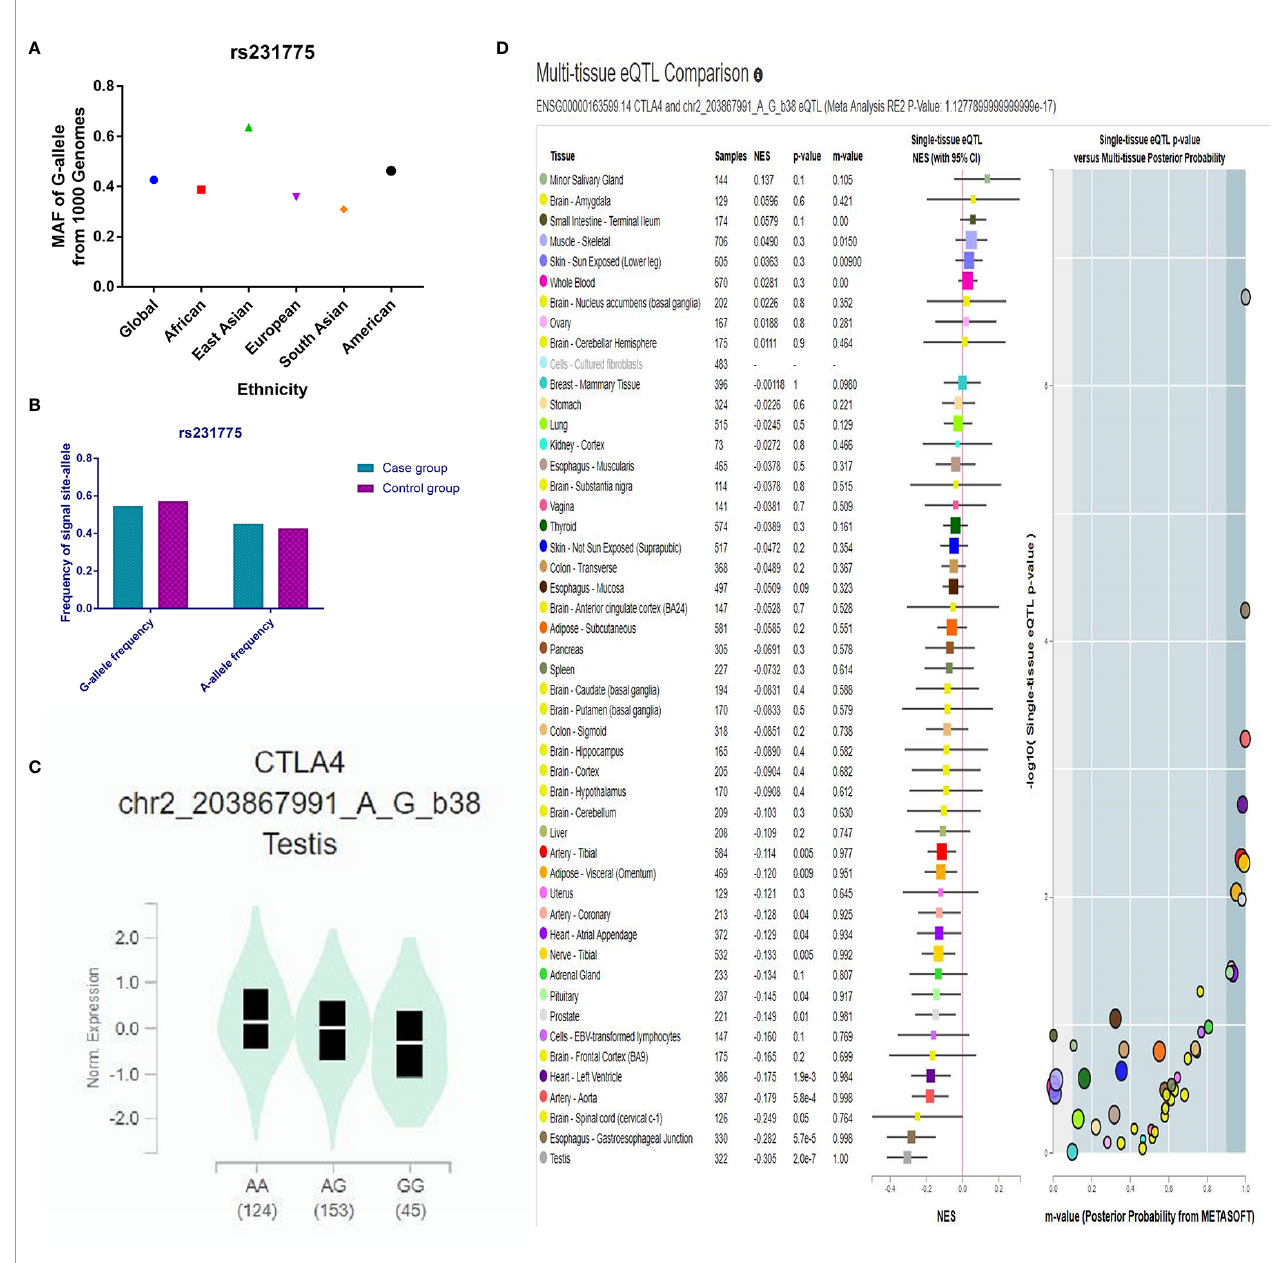
FIGURE 2 | (A) The MAF of minor-allele (mutant-allele) for CTLA-4 rs231775 polymorphism from the 1000 Genomes online database. (B) The frequency about G- allele or A-allele both in case and control groups. (C) The distribution of each genotype from online GTEx Portal (https://www.gtexportal.org/home/). (D) The risk frequency of rs231775 polymorphism in several diseases from the TCGA